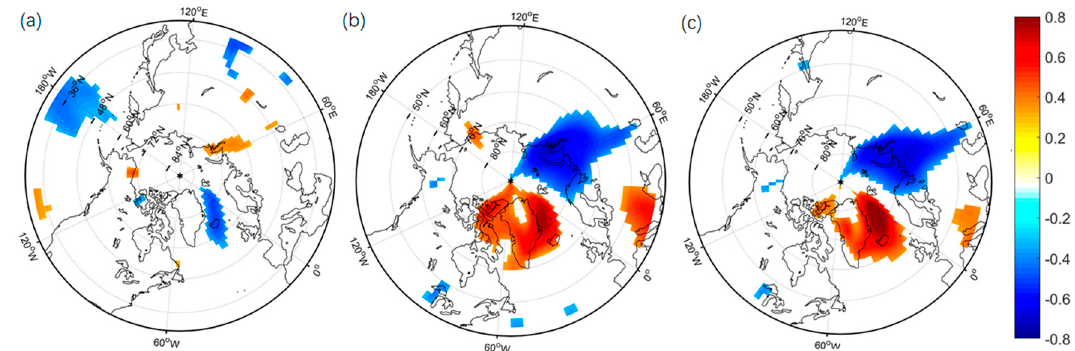
Figure 5. ( a ) Correlation coefficient distribution between the winter meridional winds in the northern hemisphere at 850 pha and autumn eastern Siberian Sea ice extent; ( b ) the Norway–Barents-centered SLP in winter; ( c ) correlation coefficient distribution between the winter meridional winds in the northern hemisphere at 500 pha and the Norway–Barents-centered 500 hpa geopotential height in winter. The colored regions passed the t test with a confidence level of 90%. All the data have been de-trended.